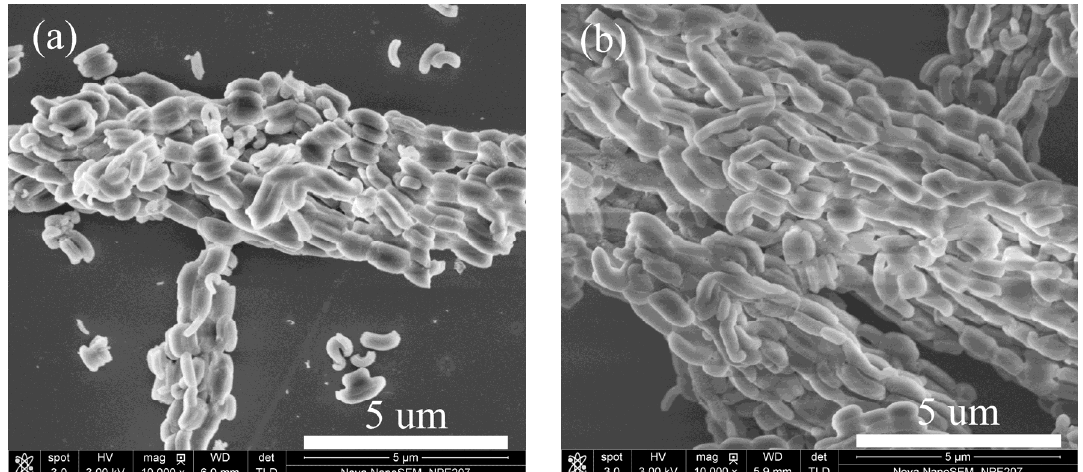
Figure 3. SEM images of ( a ) 3% V/SBA and ( b ) 7% V/SBA.